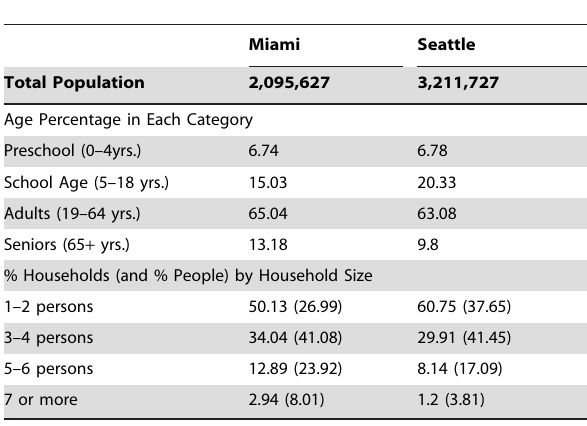
Table 1. Demographics of Miami and